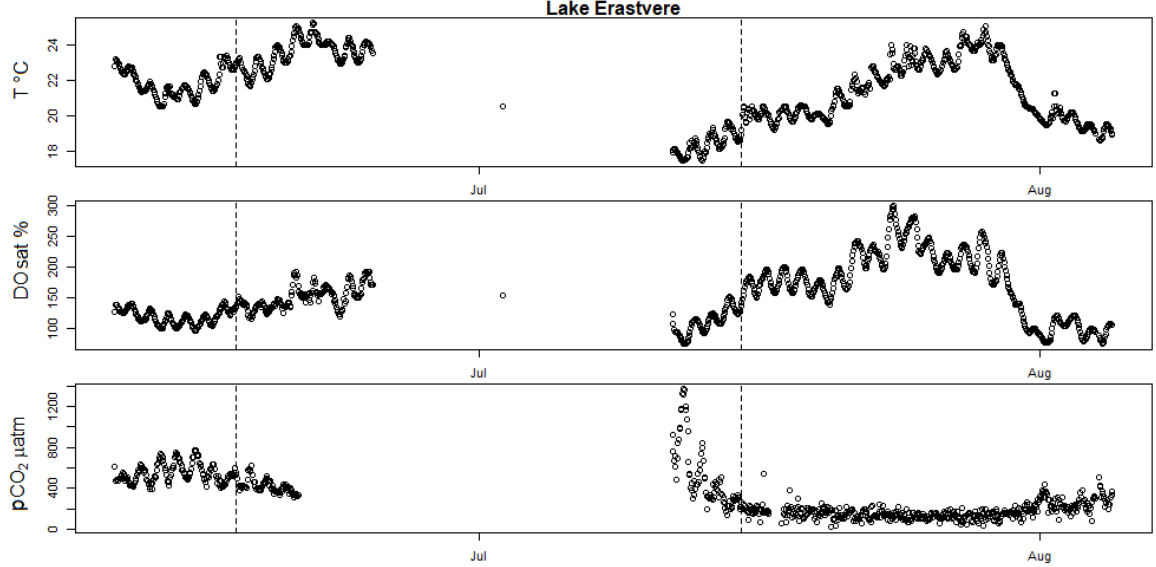
Figure A3. High-frequency measurements showing seasonal evolution of surface water T (in degrees Celsius), DOsat and pCO 2 partial pressure in Lake Erastvere. The two vertical dotted bars mark the date of the two incubation campaigns held in this lake (18.6.2019 and 23.7.2019).